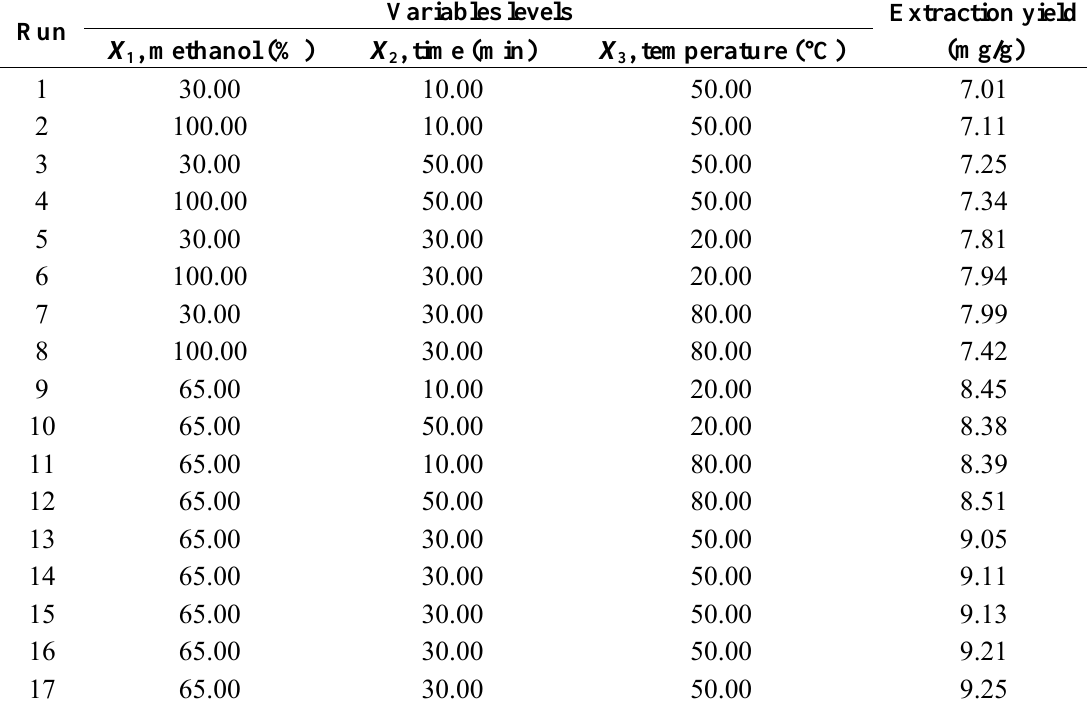
Table 1. Box-Behnken experimental design with the independent